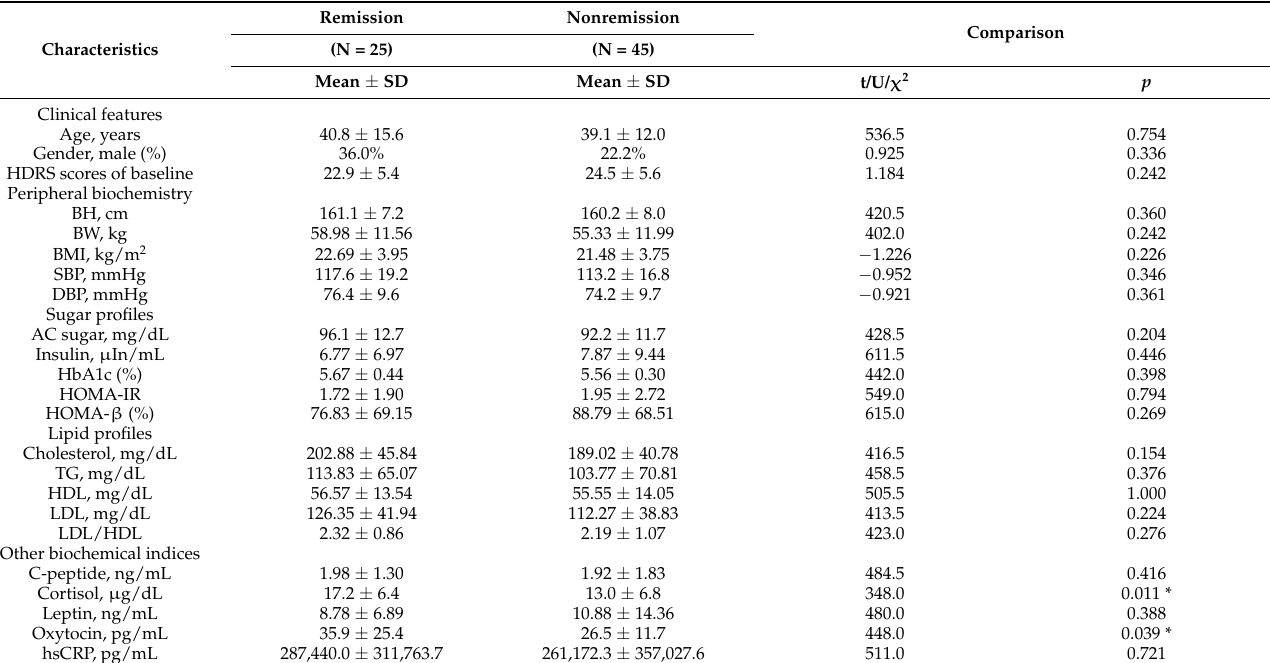
Table 1. Demographic characteristics and peripheral biochemistry of the remission and nonremis- sion patients.